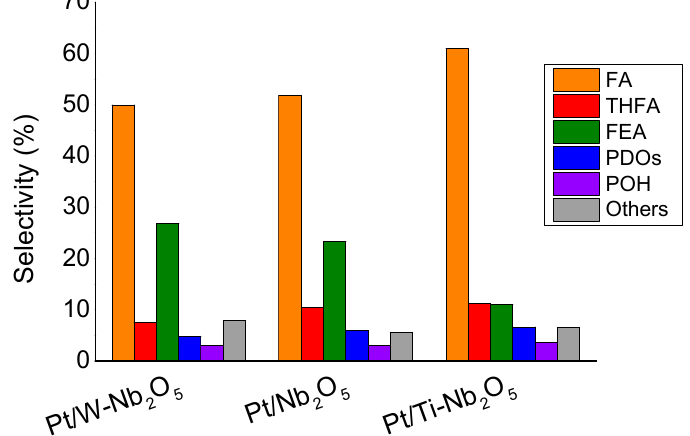
Figure 8. Product distribution of furfural hydrogenation at 90% conversion.